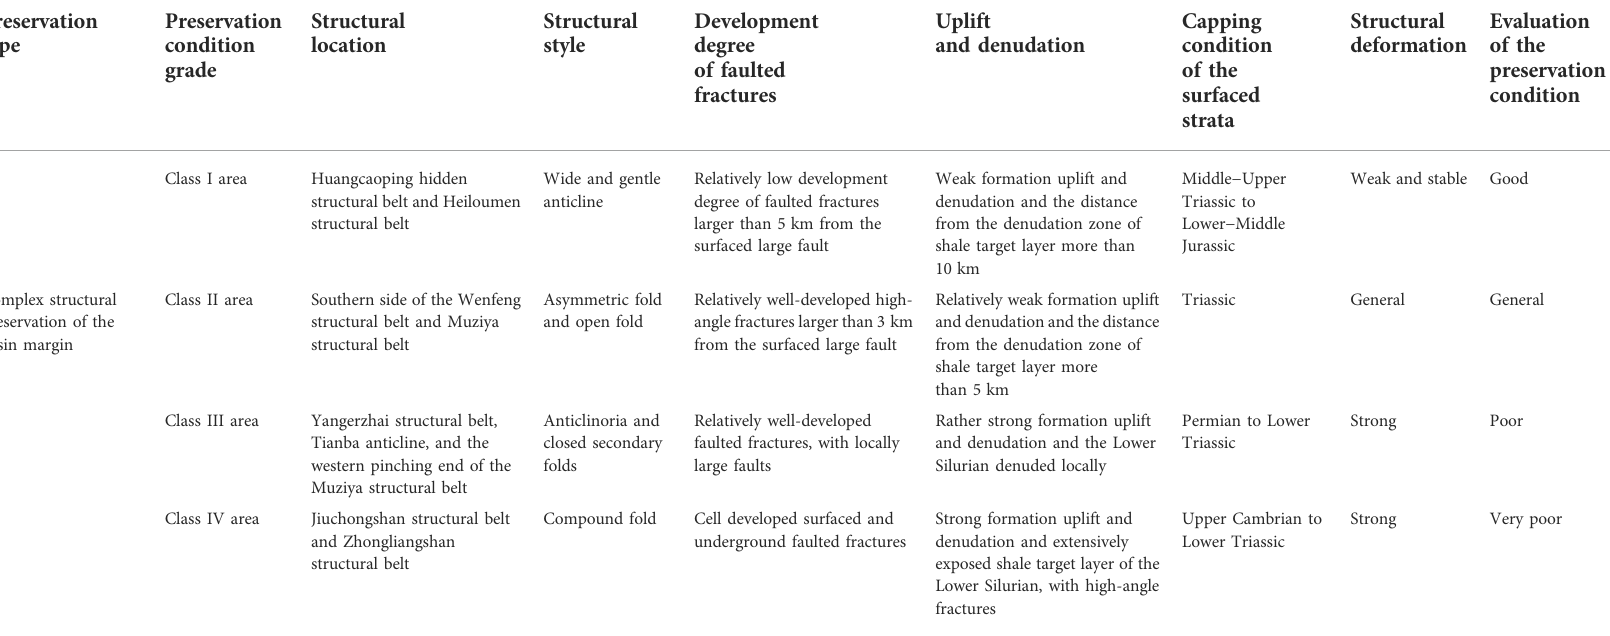
TABLE 1 Grading evaluation of structural preservation conditions of shale gas enrichment and accumulation in the Wufeng − Longmaxi